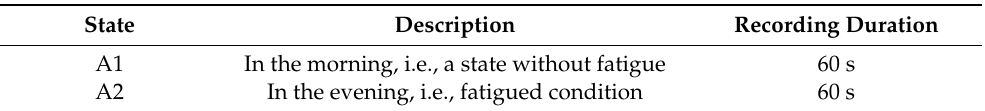
Table 3. ECG signal recordings in different states. State Description Recording Duration A1 In the morning, i.e., a state without fatigue 60 s A2 In the evening, i.e., fatigued condition 60